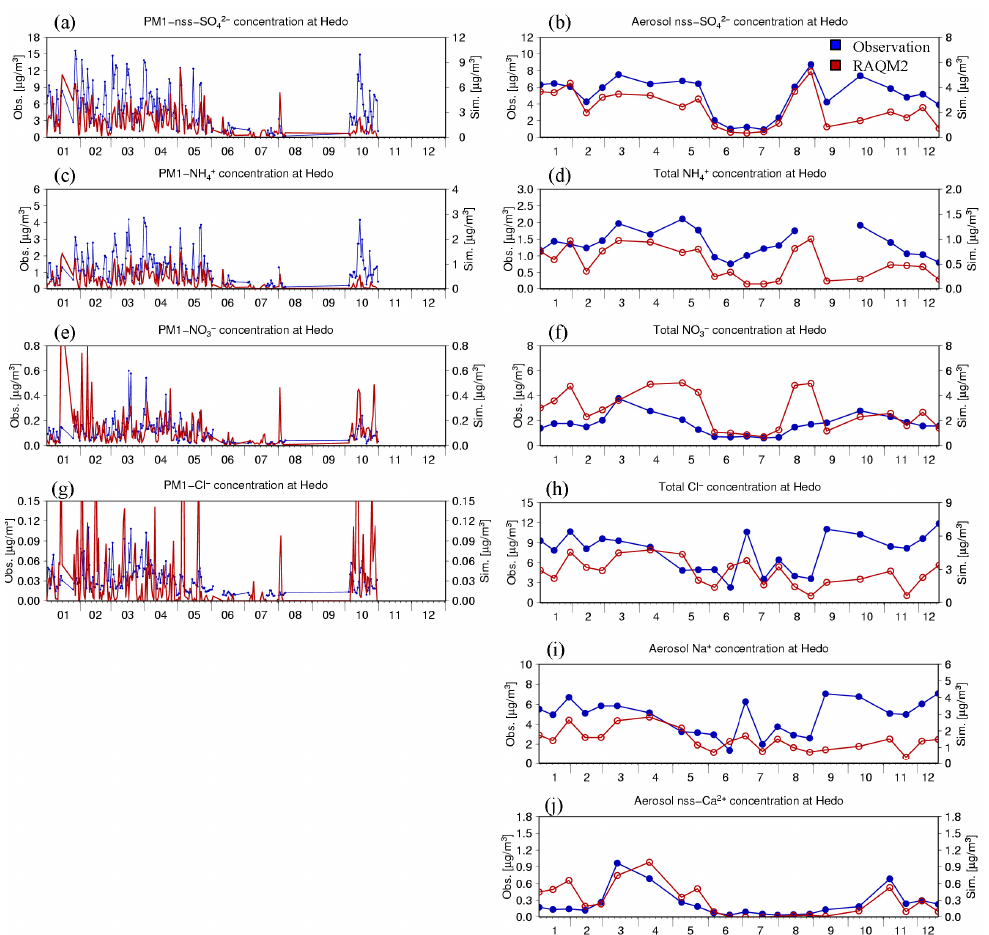
3 Figure 5. (Left) daily mean AMS measured (blue, left axis) and modeled (red, right axis) PM Fig. 5. (Left) Daily mean AMS measured (blue, left axis) and modeled (red, right axis) PM 1 (a) nss-SO 2 − (a) nss-SO 42- , (c) NH 4+ , (e) NO 3- , and (g) Cl - concentrations at Hedo (CHAAMS). (Right) 4 concentrations at Hedo (CHAAMS). (Right) The biweekly FP measured and modeled (b) nss-SO 2 − Na + , and (j) nss-Ca 2 + concentrations at Hedo biweekly FP measured and modeled (b) nss-SO 42- , (d) T-NH 4+ , (f) T-NO 3- , (h) T-Cl - , (i) Na + , 5 and (j) nss-Ca 2+ concentrations at Hedo (EANET). 6